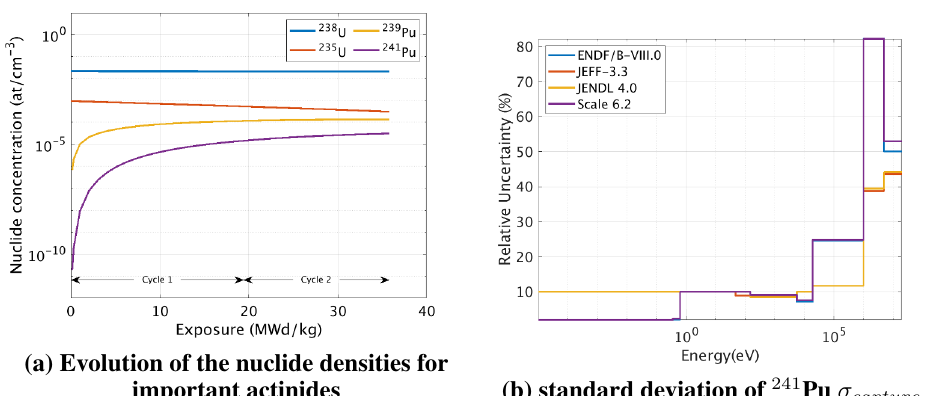
Figure 3: Additional information about the JENDL 4.0